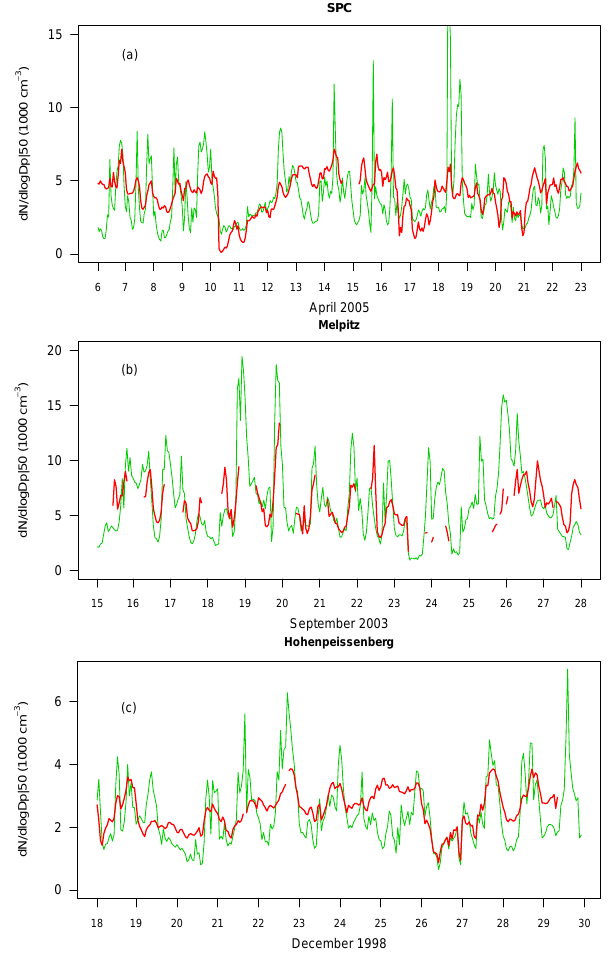
Fig. 4. Observed (green line) and predicted (red line) time series from illustrative example periods in all stations, when the combined data is used in the parameter estimation. Gaps in red line are due to missing datapoints.